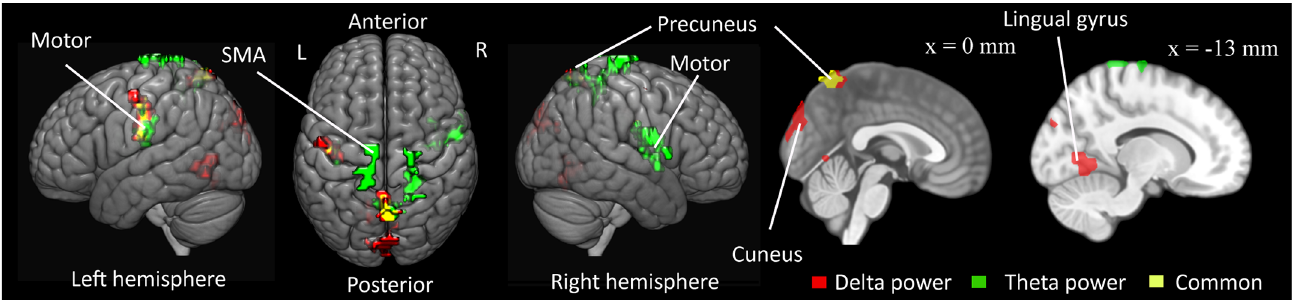
Fig 5. Brain areasfor EEG activity. The brain areas showing correlationswith the left parietaltheta and fronto-centraldelta power fluctuation. The red areas indicate a significantcorrelation between the delta power and the BOLD time series (cluster-level FWE-corrected p < 0.05). The green areas indicate a significantcorrelationwith theta power. The yellow areas indicate common areas that showedcorrelationswith delta and theta